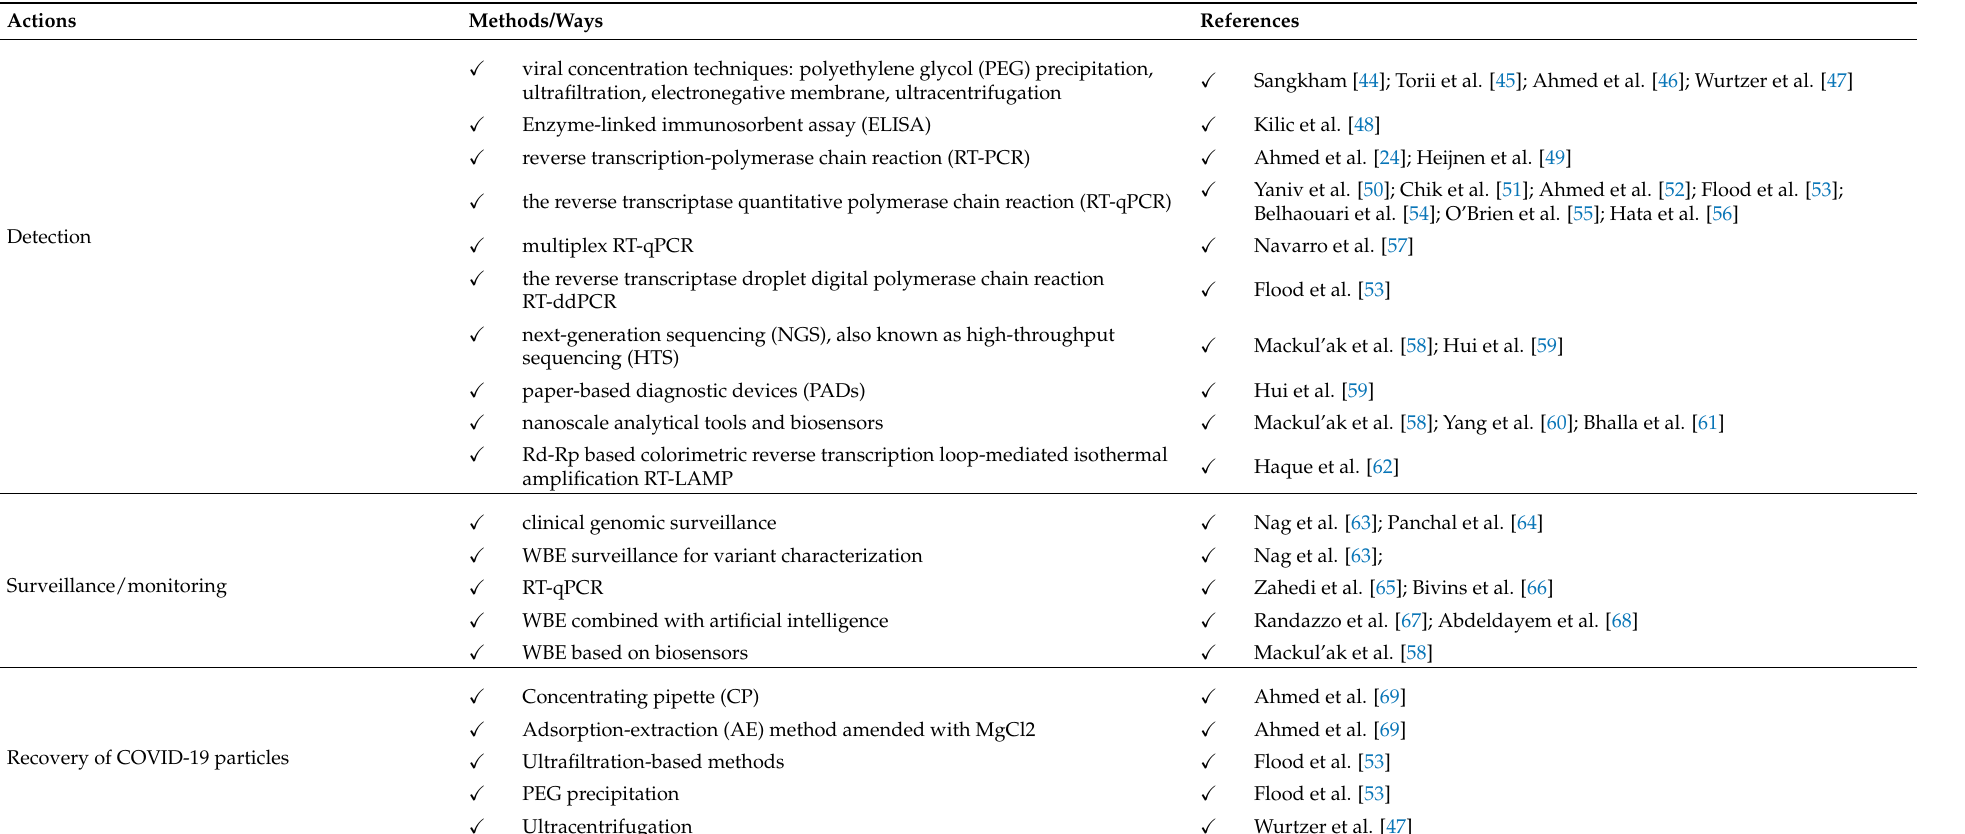
Table 3. Actions in the fight against